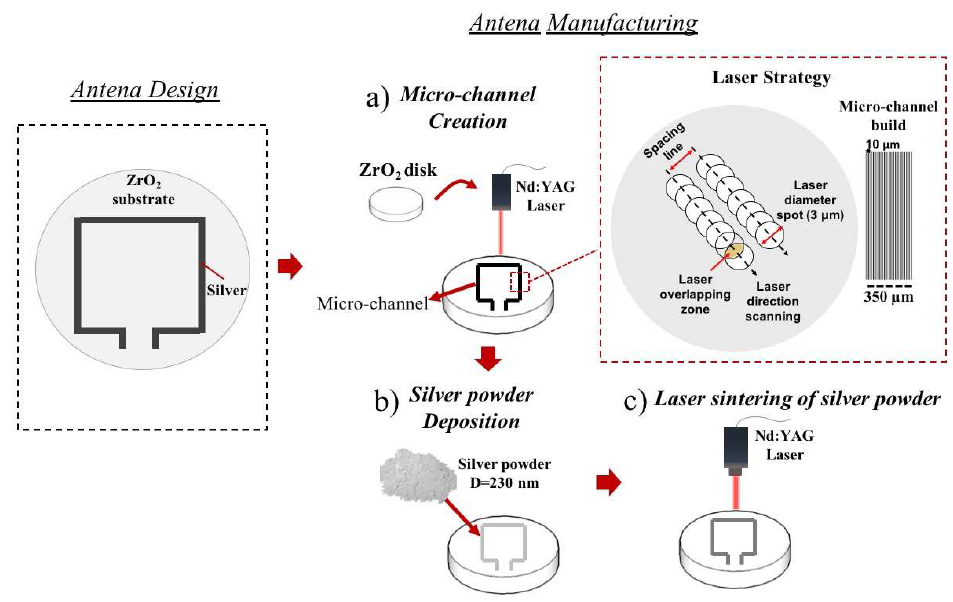
Figure 3. Schematic illustration of the antenna design and manufacturing ( a – c ), highlighting the laser strategy used to create the micro-cavity.